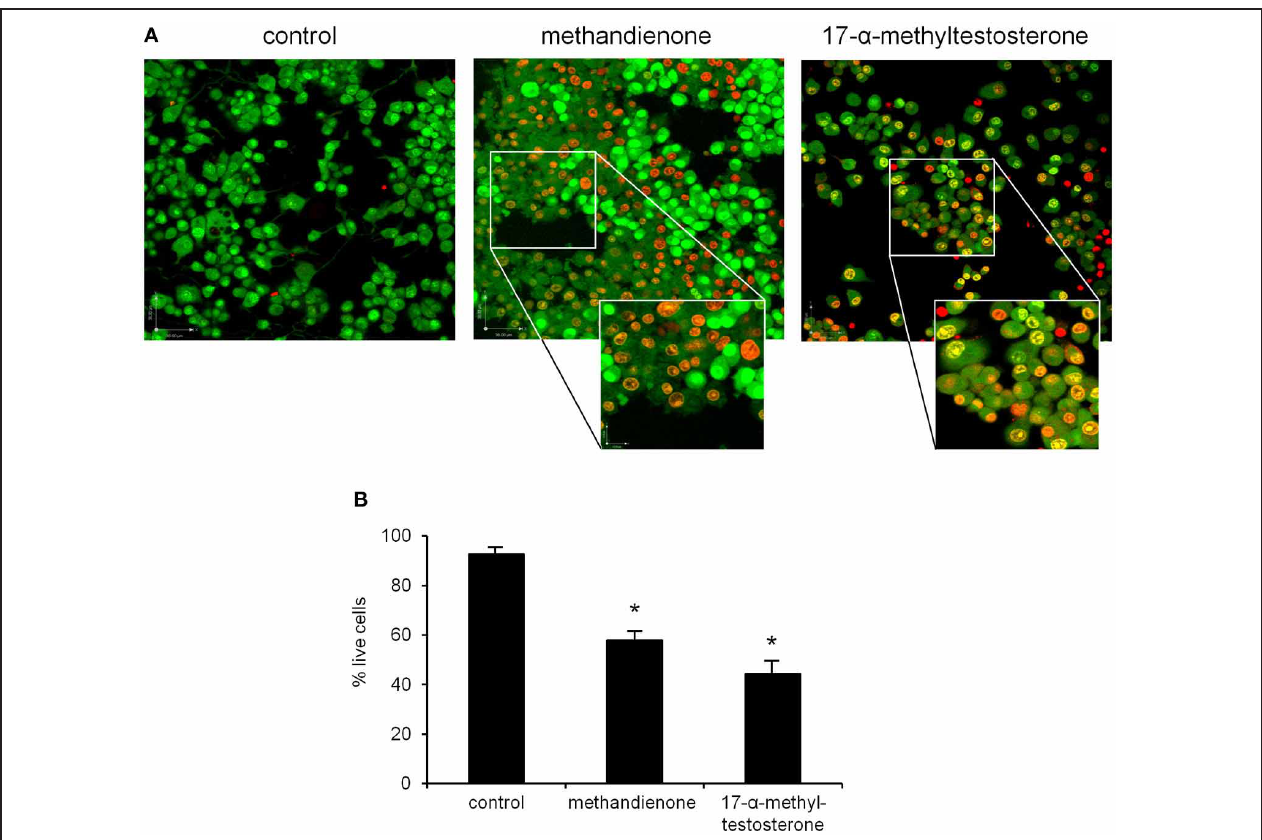
Vitality status expressed as percentage of total live cells counted in 10 high power fields ( Y-axis ) reveals that methandienone and 17- α -methyltestosterone induce cell death in PC12. Experiments were repeated at least three times and data expressed as mean ± SD ( ∗ P ≤ 0 . 05) (B)